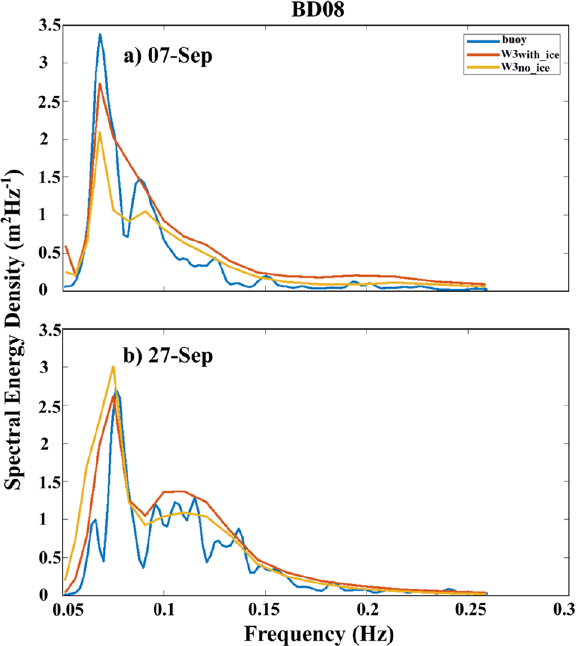
Figure 5. Spectral energy density comparison of W3 no_ice (orange) and W3 with_ice (red) with BD08 data (blue) at ( a ) 03 UTC on 07th September 2017 and ( b ) 09 UTCon 27th September